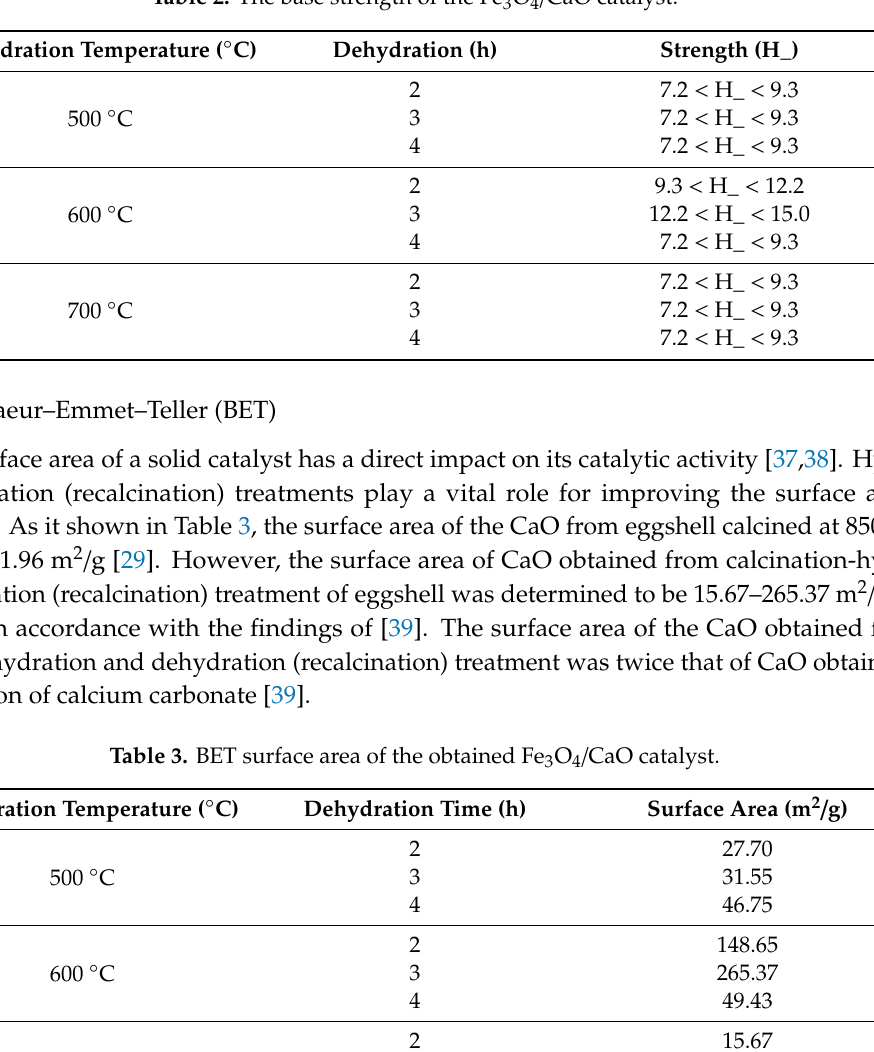
Table 2. The base strength of the Fe 3 O 4 / CaO catalyst.